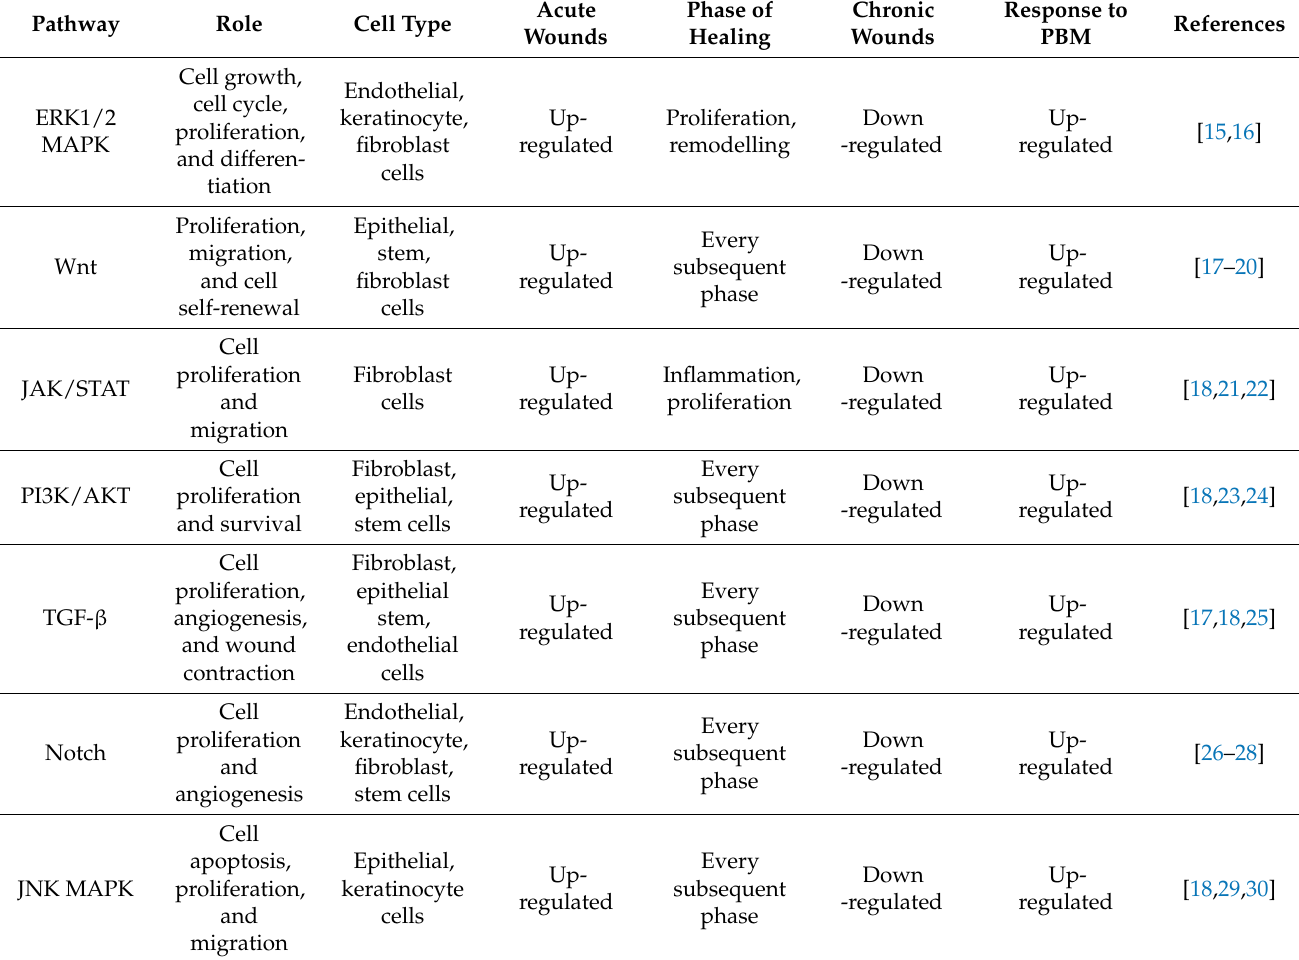
Table 1. An overview of signalling pathways involved in acute and chronic wounds and their response to PBM.